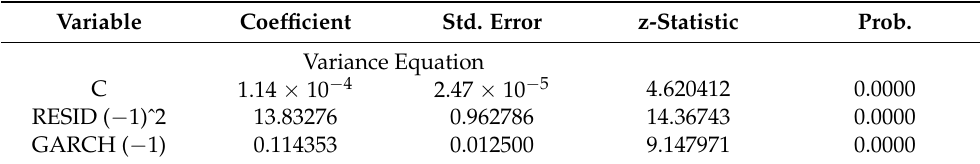
Table 8. GARCH test.